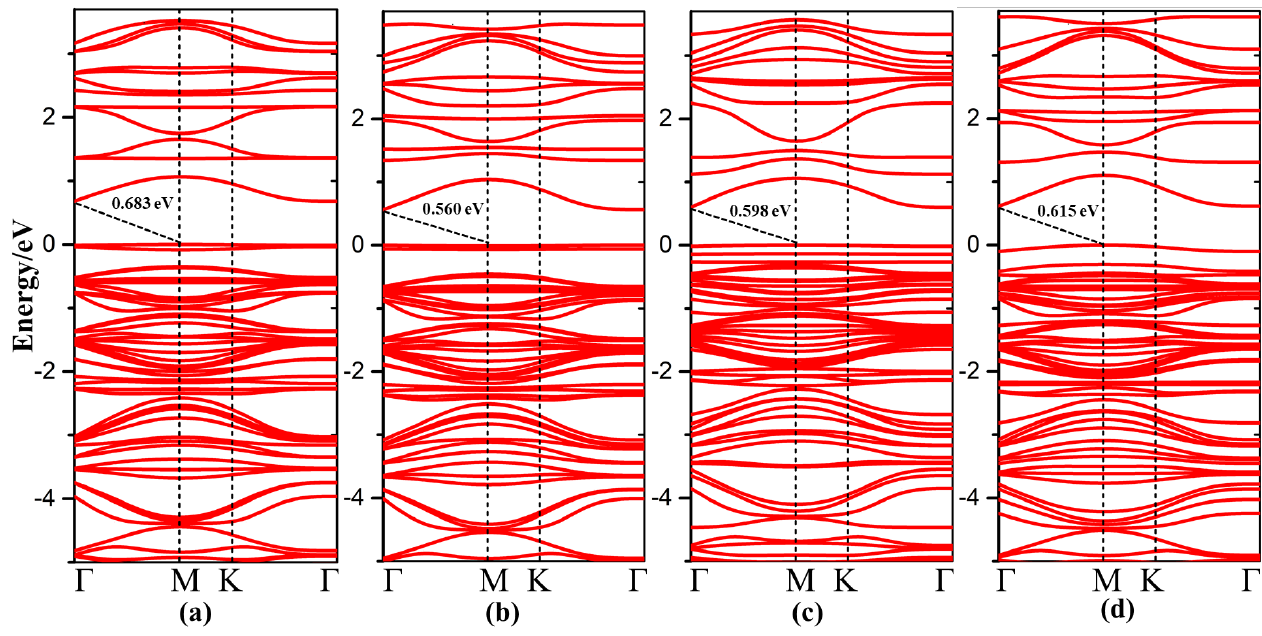
Figure 7. The band structures of the ( a ) Cr-InN monolayer, ( b ) Cr-InN/CH 4 , ( c ) Cr-InN/CO, and ( d ) Cr-InN/C 2 H 4 adsorption systems at the PBE level in the first Brillouin zone. The first Brillouin zone with high-symmetry k points: Γ (0, 0, 0), M (0.5, 0, 0), and K (0.333, 0.333, 0).